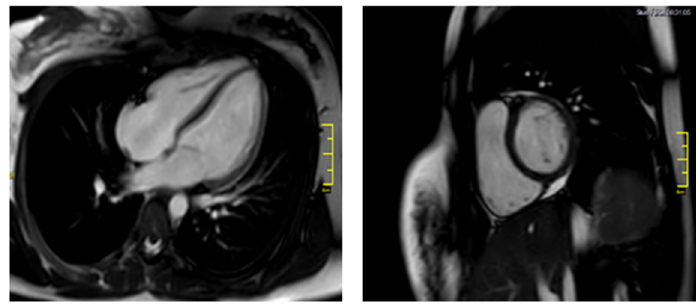
Figure 3. Follow-up